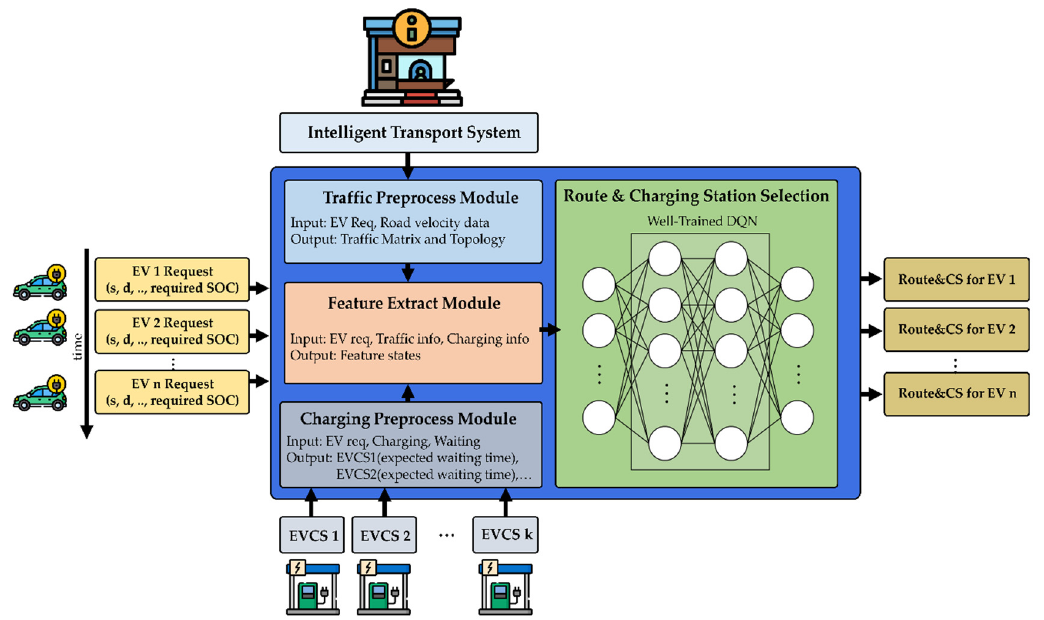
Figure 3. Deep Reinforcement Learning based EV Charging Navigation System.